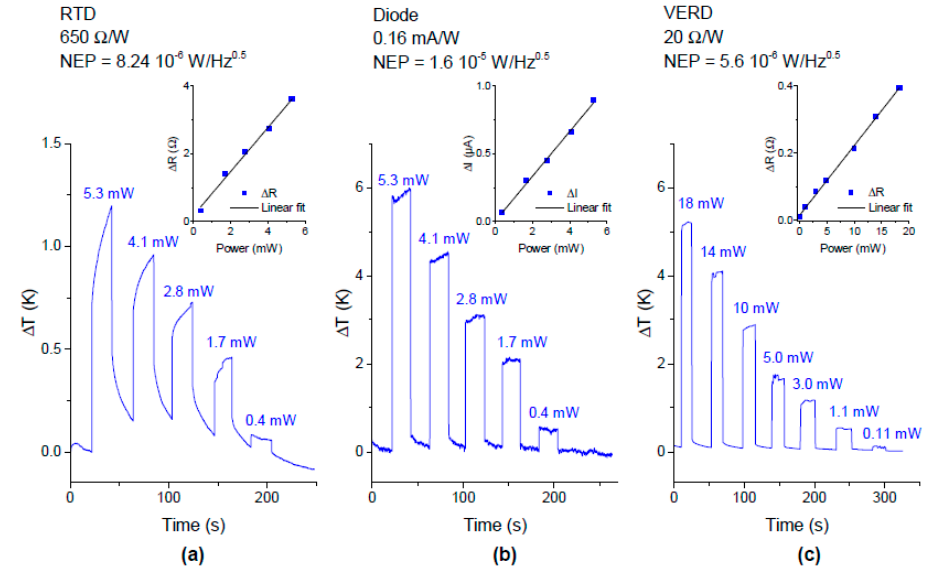
Figure 3. Temperature change of the three detectors illuminated by mid-infrared light at 4.17 µm. ( a ) RTD, ( b ) diode and ( c ) VERD. The experimentally determined responsivity and noise-equivalent power (NEP), including the current readout noise of our instrument, is indicated in each panel. The detectivity is expected to improve significantly by on-chip readout due to a reduction of the noise